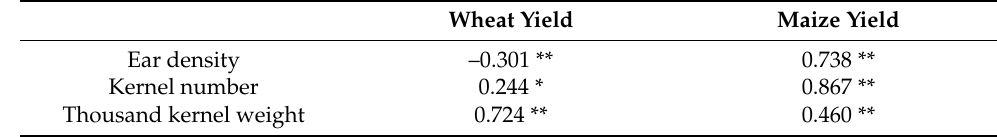
Table 2. Correlation between crop yield and yield components.